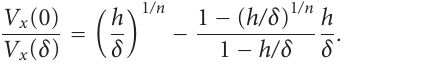
kinematic boundary condition on the gap strip. The